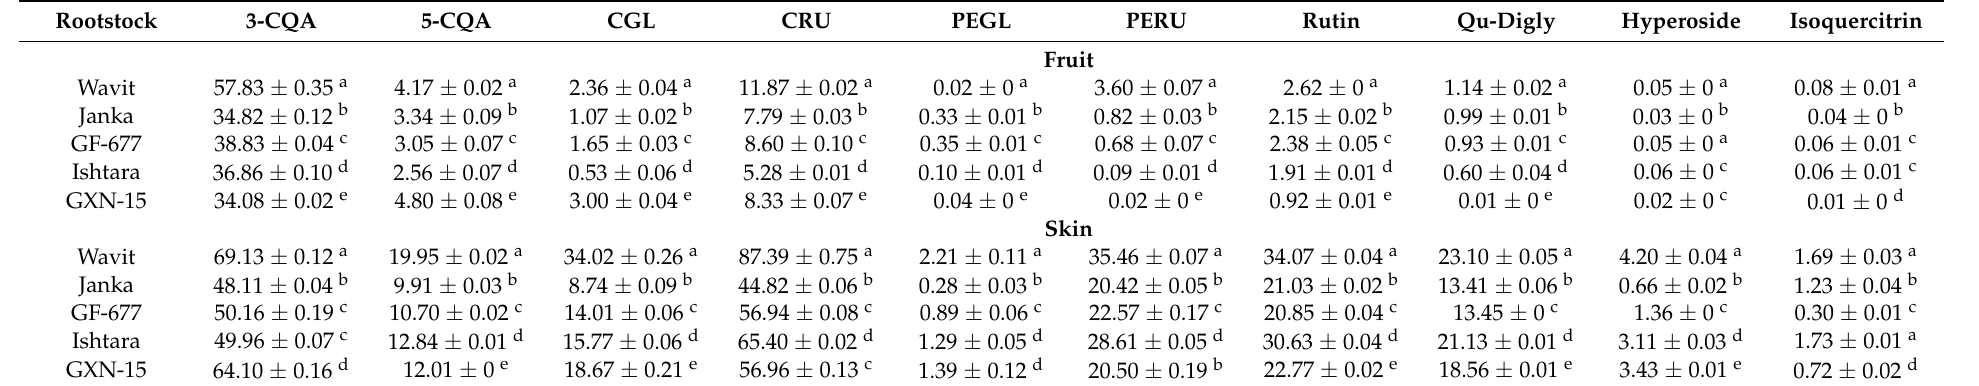
Table 4. Chlorogenic acids, anthocyanins, and flavonoids quantified in fruit and fruit skins of plums growing on different rootstocks by using